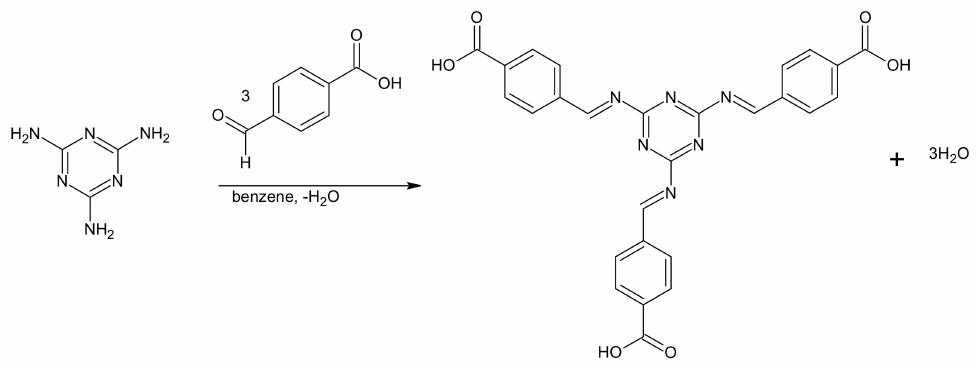
Scheme 1. Synthesis of MT.